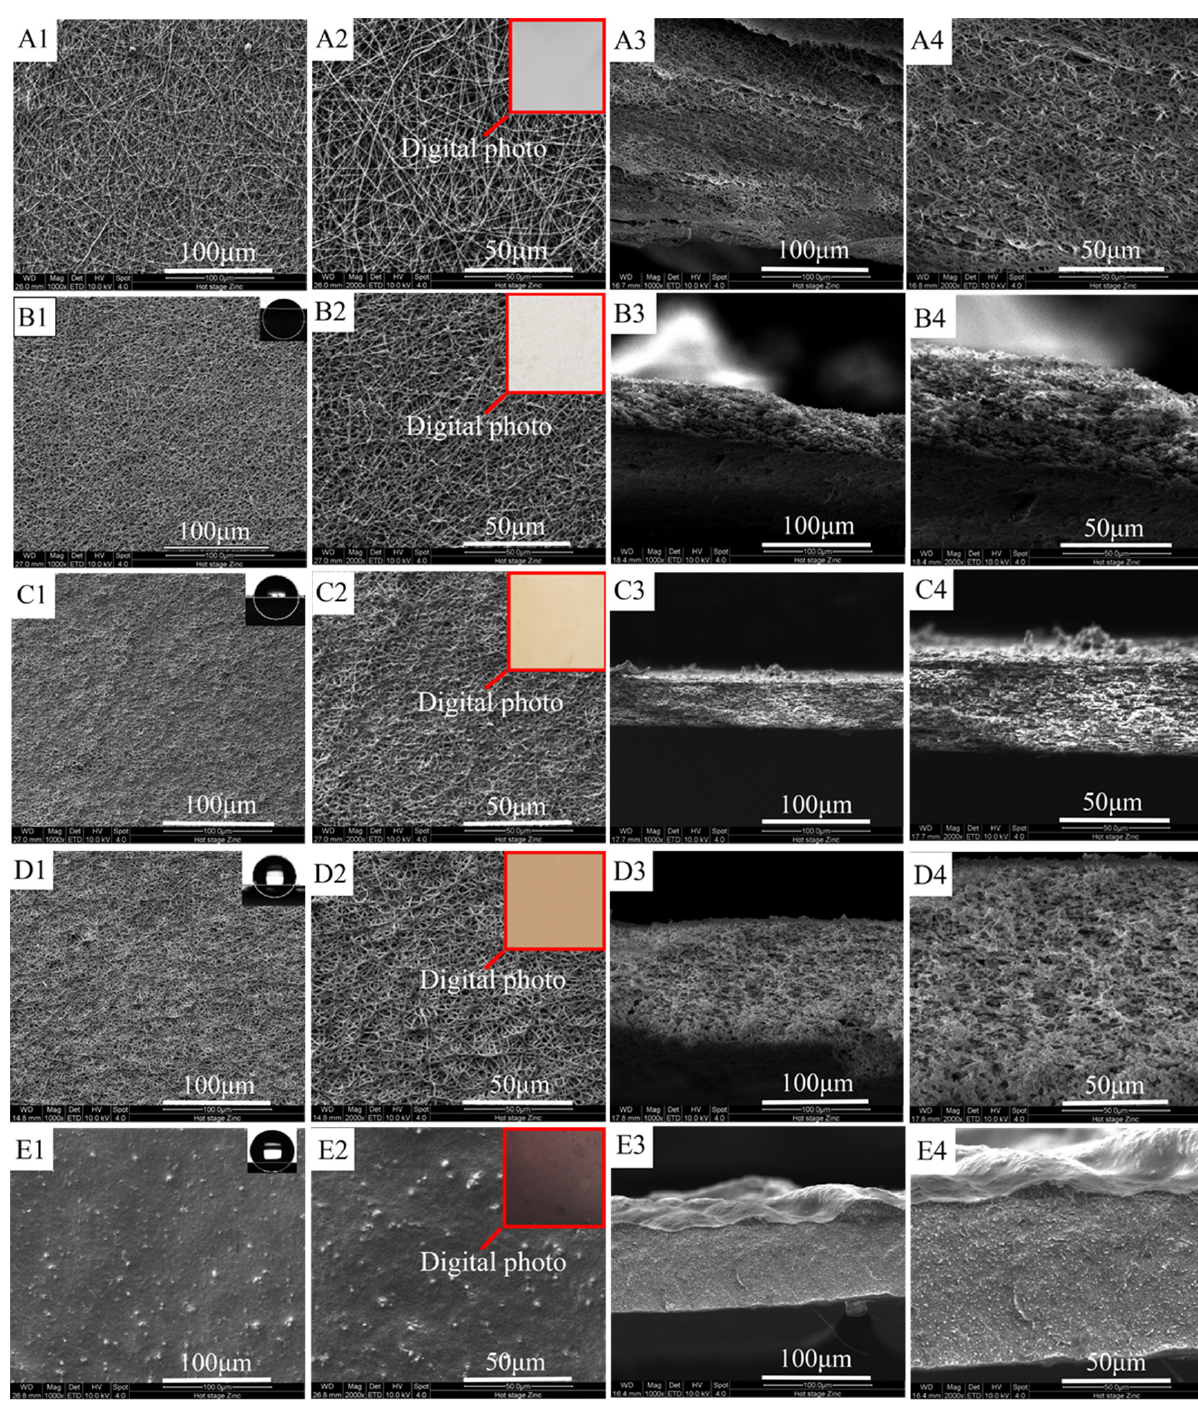
Figure 6. Morphologies of ultrafine fibrous FEP porous membranes at different sintering temperature (FEP/PVA mass ratio 1:6; ( A ): nascent membrane; ( B ): 260 °C; ( C ): 280 °C; ( D ): 300 °C; ( E ): 320 °C; 1: 1000× surface; 2: 2000× surface; 3: 1000× cross-section; 4: 2000× cross-section).